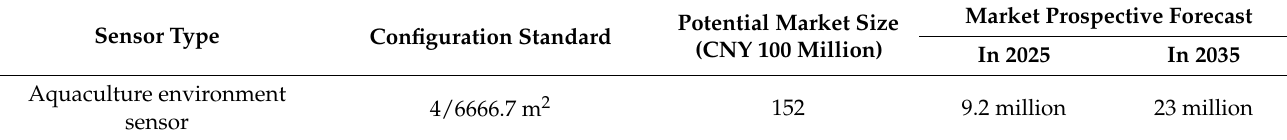
Table 8. Potential scale and prospective forecast of the aquaculture (freshwater) sensor